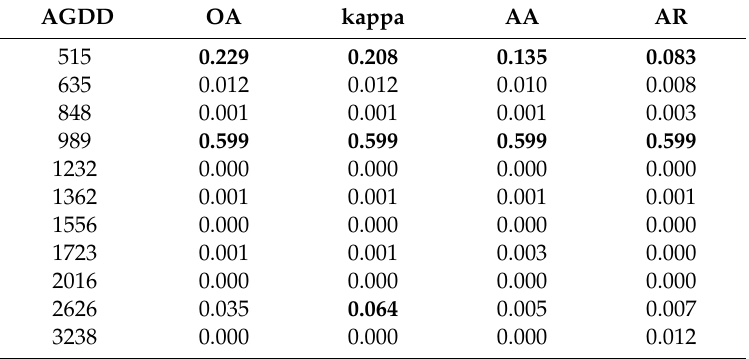
Table A4. p -values of the significance test ( p < 0.05) for the di ff erence between the NIR-RGB and RGB setting for overall accuracy (OA), Kappa, average accuracy (AA), and average reliability (AR). Not significant di ff erences are marked in